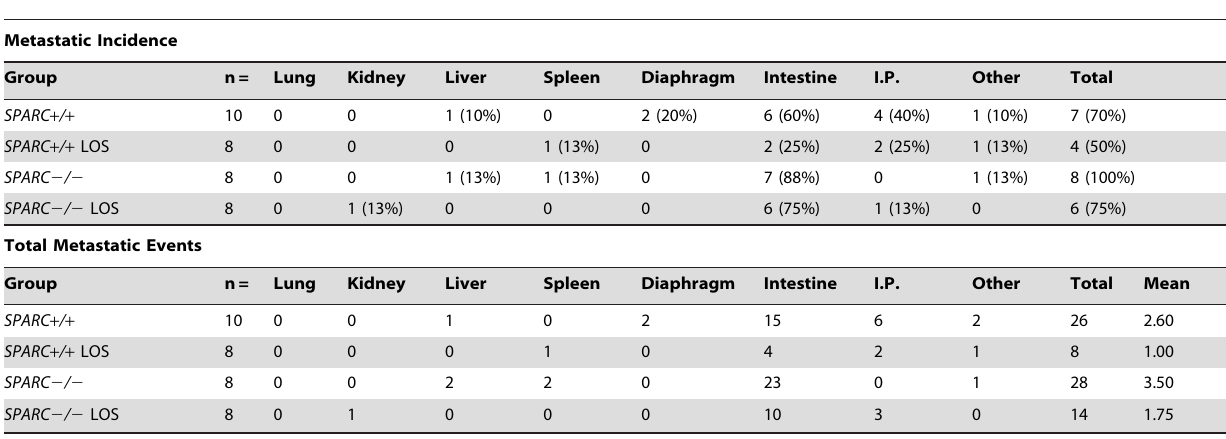
Table 3. The effect of losartan on Pan02